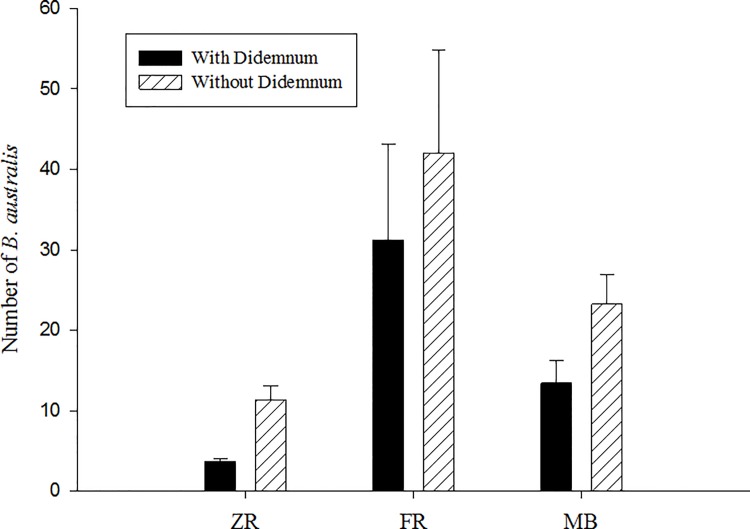
Counts of Batillaria australis with and without D. perlucidum colonies sampled from 9mm sediment cores and pooled from 3 sites in April and June 2014 and March 2015.(n = 9 with D. perlucidum per site and 9 without D. perlucidum per site).